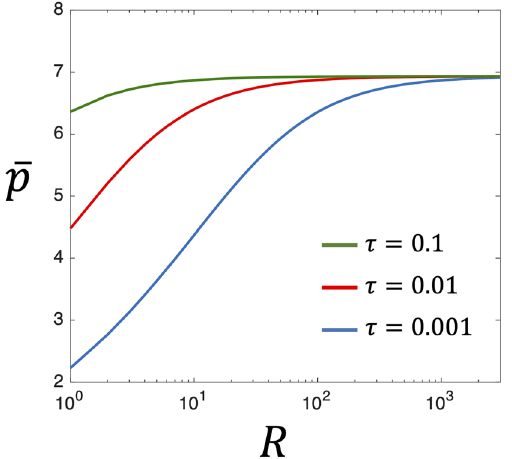
Figure 3. Steady state protein concentration ¯ p in the TXTL reaction with NAF control under the steric effect. ¯ p is plotted according to Eq. (14) as a function of radius R . The three curves represent size dependence of ¯ p for each different parameter τ (Blue: τ = 0.001 , Red: τ = 0.01 , τ = 0.1 ). The other parameters are r 0 = 10 , γ p = 0.03 , α b = 1 , α s = 0.001 , and (cid:31) = 0.01